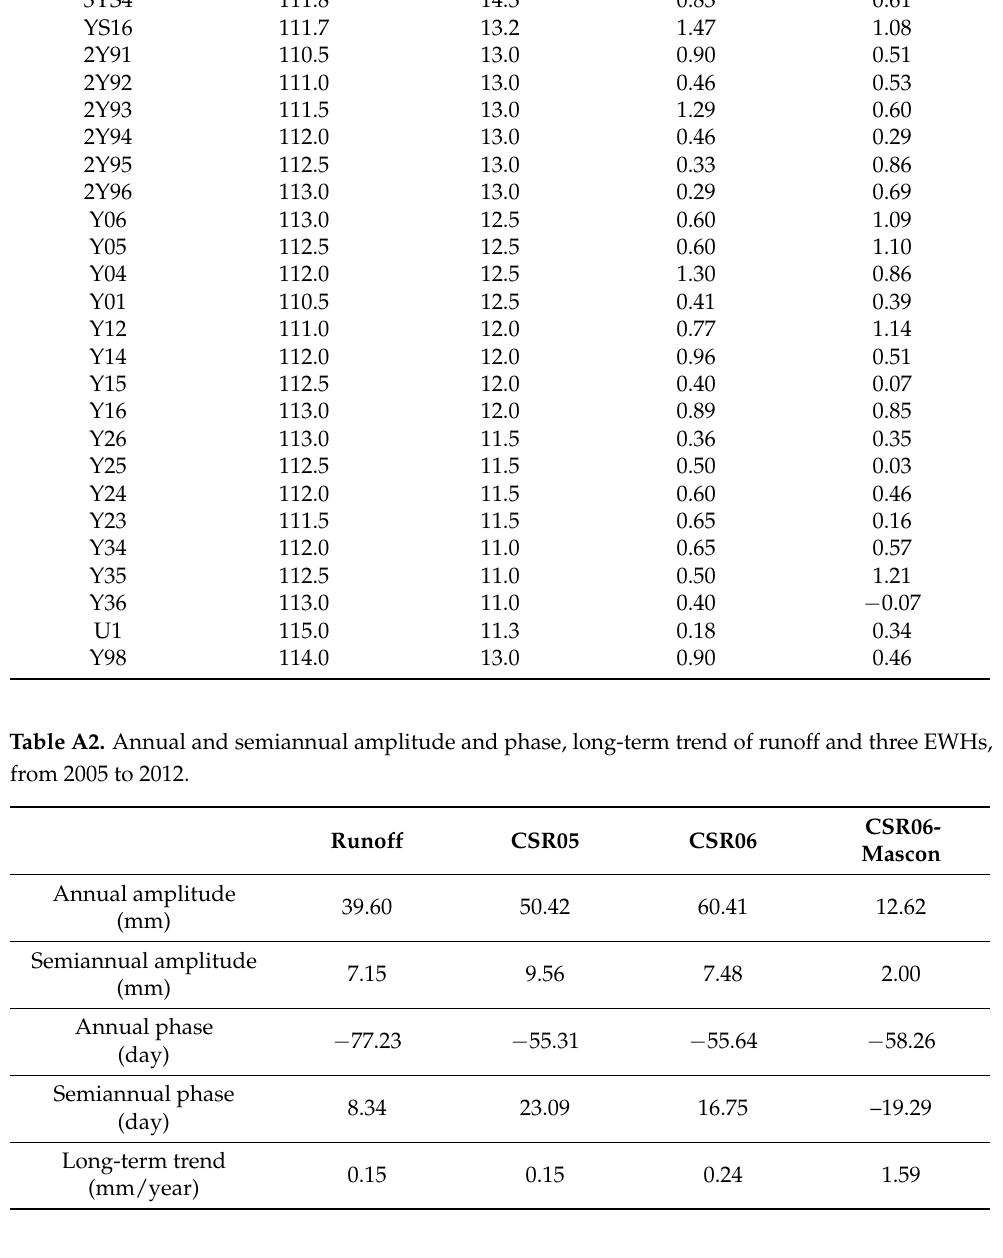
Table A3. The paired t-test results for GRACE-derived time lag and isotope-derived age based on the 17 selected isotope